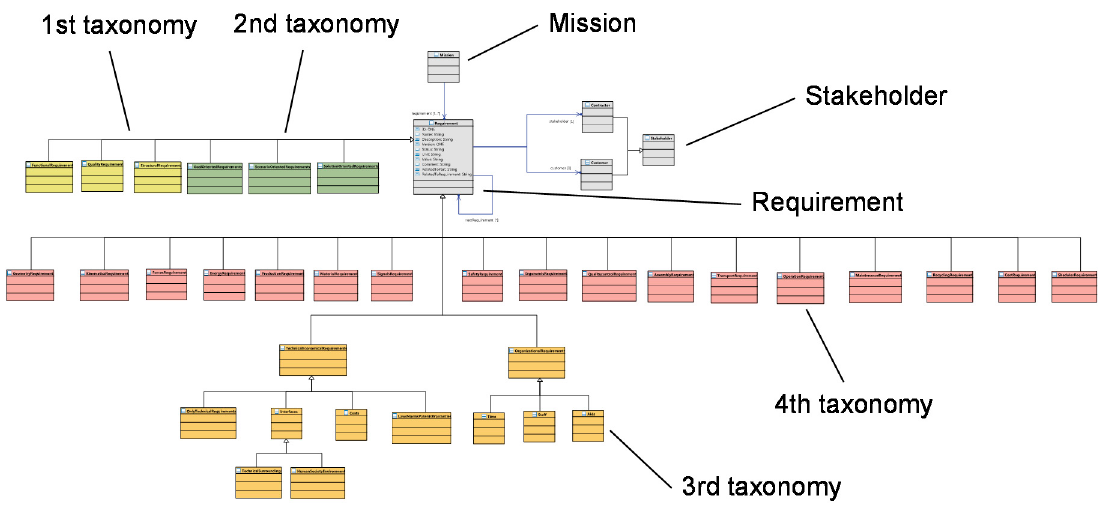
Figure 13. Implemented class diagram for classification and structuring of database requirements.